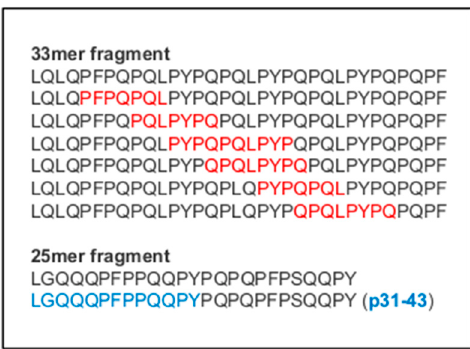
Figure 1. Amino acid sequence of the 33-mer and 25-mer fragments of the α -gliadin. Major immunogenic epitopes are indicated in red, while the sequence of the non-immunogenic fragment p31-43 is shown in blue.